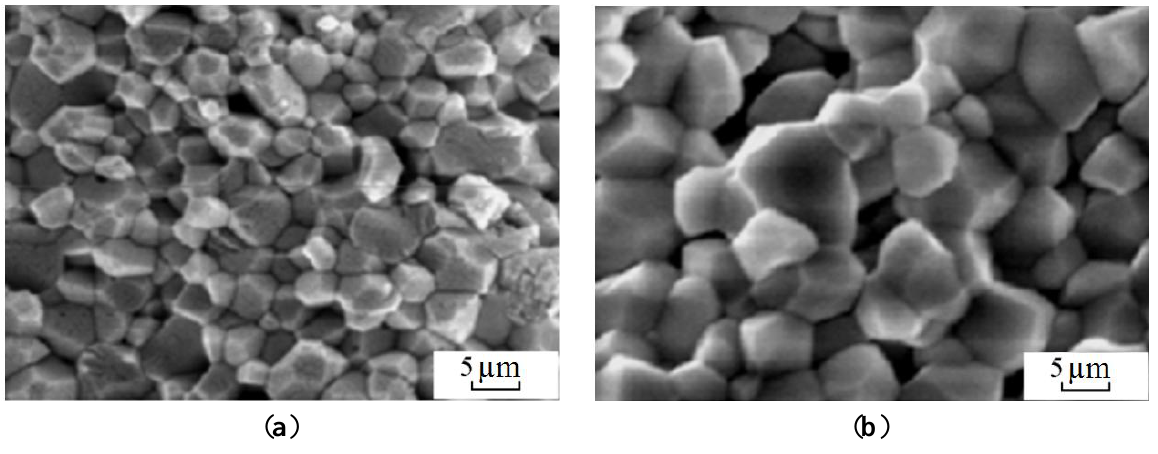
Figure 31. Microstructure of the sintered Al